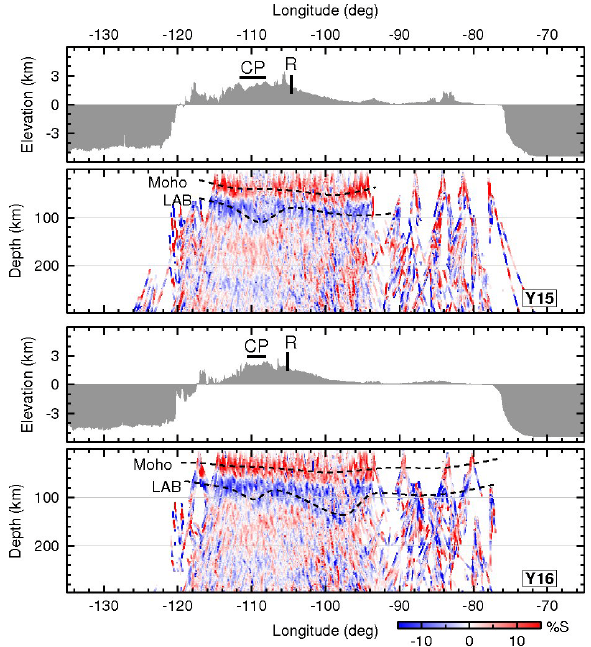
Fig. 8. Migrated S receiver functions along profiles Y11 and Y12 as Fig. 10. Migrated S receiver functions along profiles Y15 and Y16 Figure 8 in Fig. 3. as in Fig. 3. It seems that along profile Y16 besides the marked LAB Migrated S receiver functions along profiles Y11 and Y12 as in Fig. 3. Migrated S receiver functions along profiles Y15 and Y16 as in Fig. 3. It seems that another, shallower blue signal exists. The north-south profiles X07– X09 confirm deepening of the LAB at the same location. The shal- along profile Y16 besides the marked LAB another, shallower blue signal exists. The lower blue signal in profile Y16 might be caused by heterogeneities north-south profiles X07-X09 confirm deepening of the LAB at the same location. off the The shallower blue signal in profile Y16 might be caused by heterogeneities off the profile.